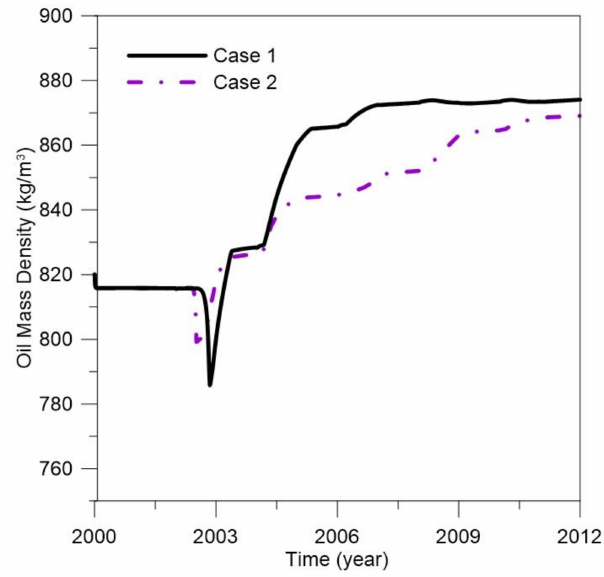
Figure 4. Oil density during CO 2 and impure CO 2 WAG injection.